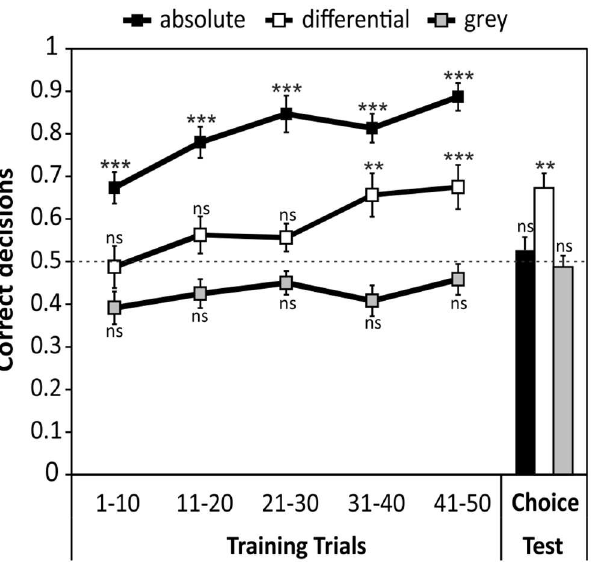
Fig 3. Learning performance and color discrimination (choice) test of bees of the three experimental groups. One group of bees was trained with absolute conditioning to one color (against the grey background, black squares). A second group received differential conditioning with one color rewarded and a second color unrewarded(open squares). A third (control) group experienced the training without conditioning to color stimuli (grey squares). See material and methods for the definitionof “correct” decision in the grey control group. All groups completed 50 conditioning trials, followedby a choice test, where all bees had to choose between the two colors used in the experiment (blue and turquoise). Horizontal grey dashedline indicates chance level (random choice). All values are mean proportion( ± SEM) of correct decisions; ** p < 0.01; *** p < 0.001; ns: not significant; absolute: N = 15; differential: N = 16; grey: N =